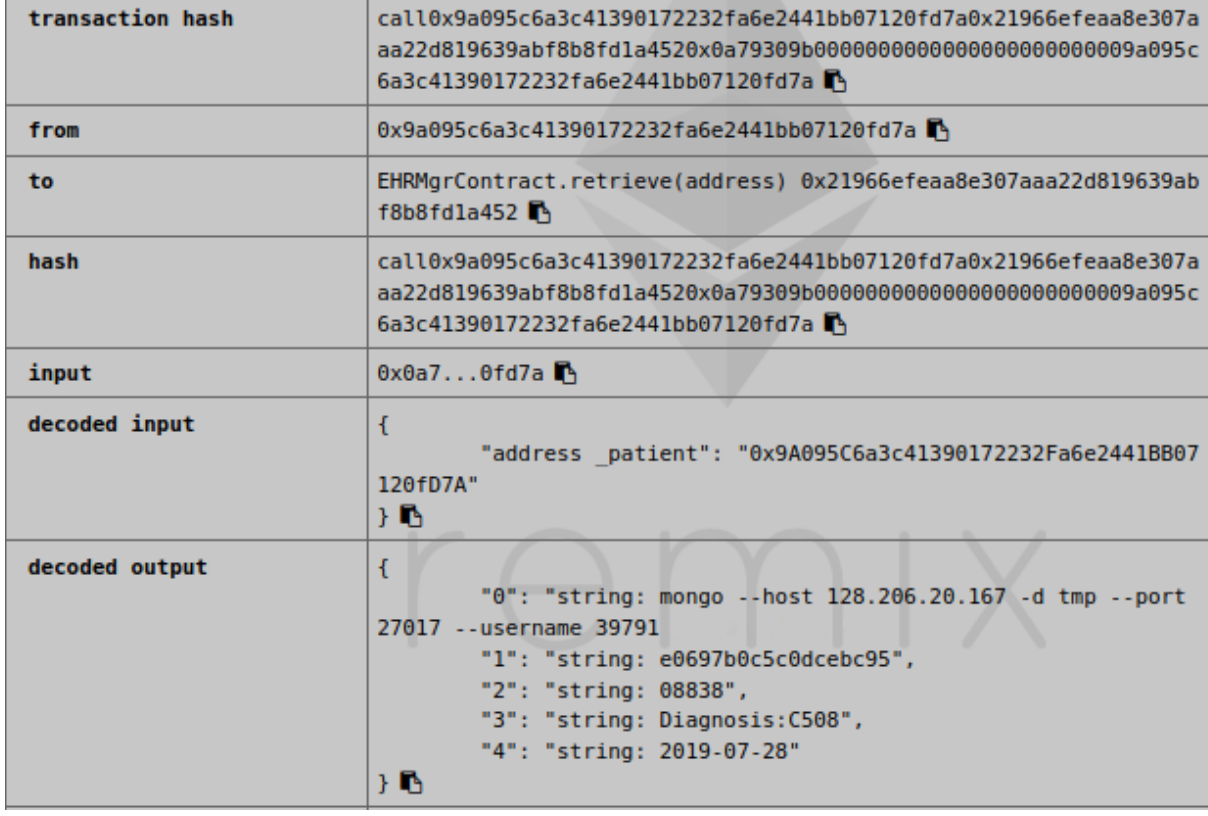
Figure 3. Example of a patient’s metadata retrieved through blockchain. The information is decoded by the Remix web-based integrated development environment, which is connected to the retrieving blockchain node. The patient’s metadata contain data location, key cipher, data set ID, data set description, and creation